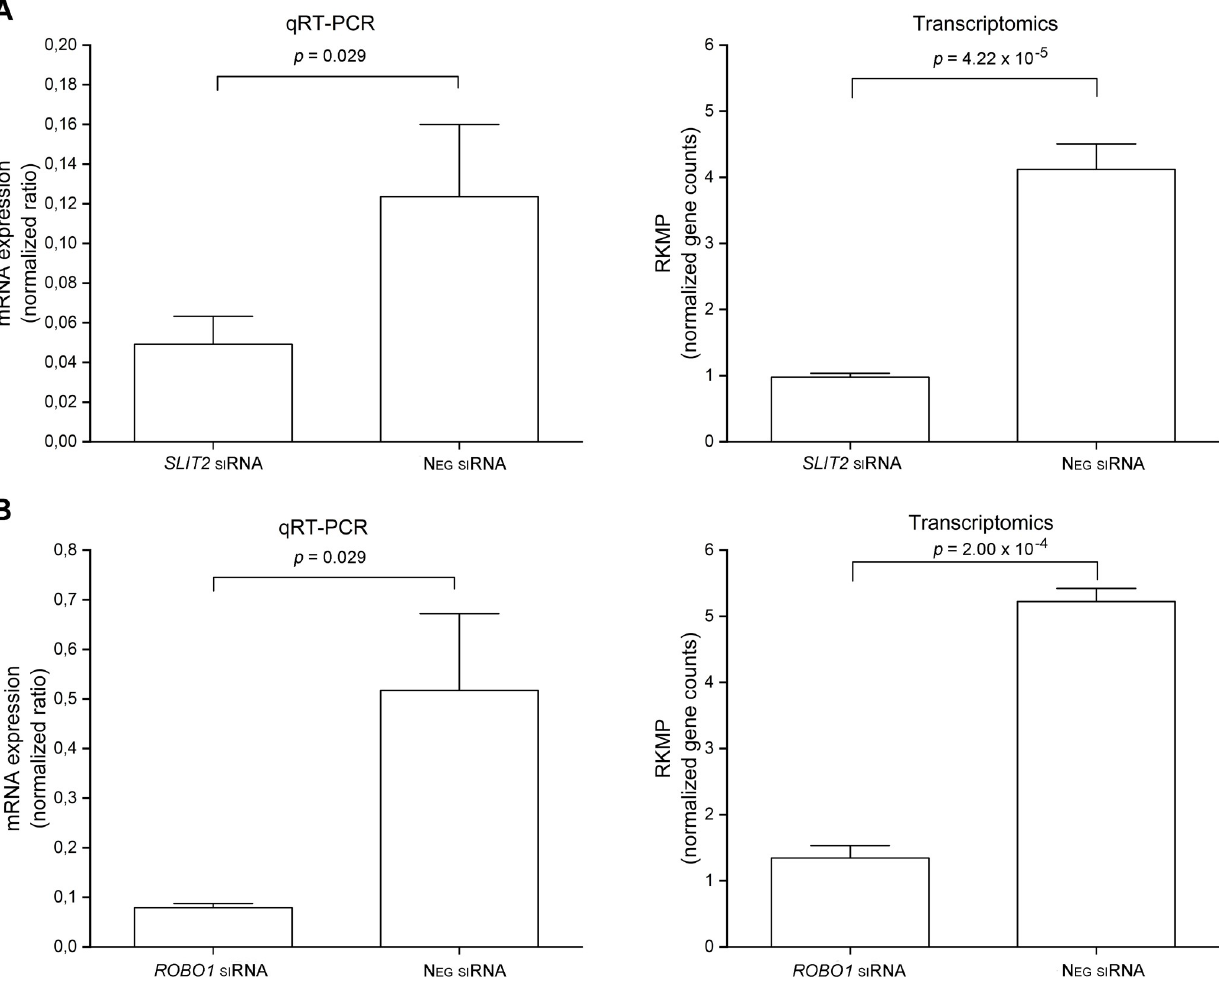
Fig 5. mRNA expression level changes after gene knockdown. SLIT2 (A) and ROBO1 (B) were post-transcriptionally knocked down with siRNA in human placental trophoblast continuous cell line HTR8/SVneo. mRNA levels of cells in which SLIT2 or ROBO1 were knocked down was compared with mRNA levels from siRNA negative treated control cells. Expression levels of the genes were first determined by qRT-PCR (levels normalized against housekeeping gene CYC1 mRNA levels). According to qRT-PCR, silencing percentage of SLIT2 was 60% and silencing percentage of ROBO1 was 85%. Gene expression levels also determined with high-throughput RNA sequencing. Reads per kilobase of exon per million reads mapped (RKPM) is a normalized gene count value determined in transcriptomic analysis. According to transcriptomics data, silencing percentages were 75% for SLIT2 and 74% for ROBO1. Columns represent median and SD